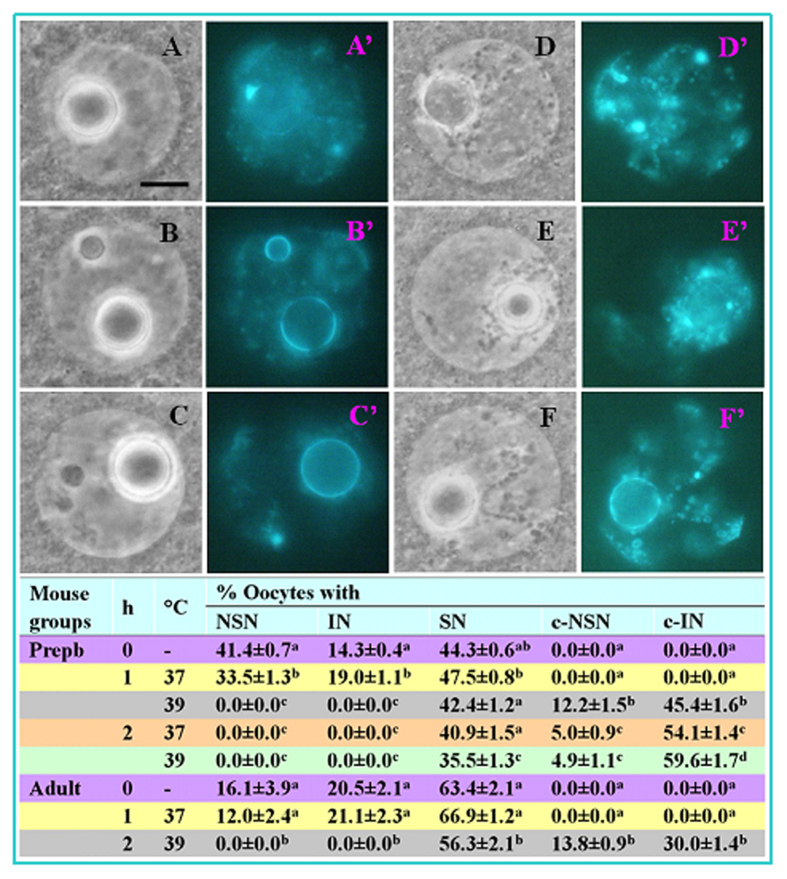
GV chromatin configurations of mouse oocytes before (0 h) or following OH for 1 or 2 h at 37 or 39 °C.Photographs (A) and A’, (B) and B’, (C) and C’, (D) and D’, (E) and E’, and (F) and F’ are the same oocytes observed with phase contrast and fluorescence, respectively, after Hoechst 33342 staining. A’, B’ and C’ show, respectively, oocytes with NSN, intermediate (IN) and SN configurations before OH. D’ shows an oocyte with condensed NSN (c-NSN) configuration, and E’ and F’ show oocytes with condensed IN (c-IN) configuration. Original magnification ×1300. Scale bar is 10 μm. The table shows percentages of oocytes with different chromatin configurations. a-d: Values without a common letter in their superscripts differ significantly (P < 0.05) in the same column. Each treatment was repeated 5 times with each replicate containing 50–60 oocytes.